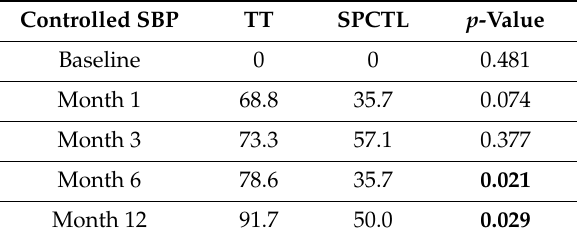
Table 2. Proportion of participants meeting the 2017 ACC / AHA Revised Guidelines for Controlled SBP ( < 130 mmHg). Controlled SBP TT SPCTL p -Value Baseline 0 0 0.481 Month 1 68.8 35.7 0.074 Month 3 73.3 57.1 0.377 Month 6 78.6 35.7 0.021 Month 12 91.7 50.0 0.029